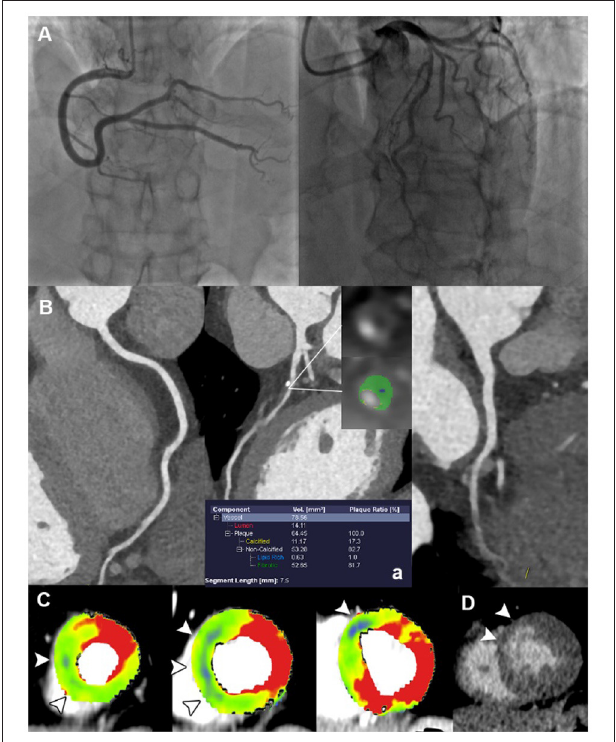
FIGURE 3 | Representative case of plaque disruption in a 61-year-old male with ACS and non-obstructive ICA. (A) ICA revealed mild stenosis at proximal LAD, without presence of obstructive lesion. (B) CPR images showed mixed plaque at proximal LAD with the presence of LAP, PR, NRS, and SC, indicating a typical HRP. (C) Short-axis views of CT-MPI showed significantly reduced myocardial blood flow within LAD territory (white arrowhead). (D) LIE image showed the subendocardial late enhancement within LAD territory (white arrowhead). ACS, acute coronary syndrome; CPR, curved planar reformation; CT, computed tomography; ICA, invasive coronary angiography; LAD, left anterior descending; LAP, low-attenuation plaque; LIE, late iodine enhancement; MPI, myocardial perfusion imaging; MVO, microvascular obstruction; NRS, napkin-ring sign; PR, positive remodeling; SC,